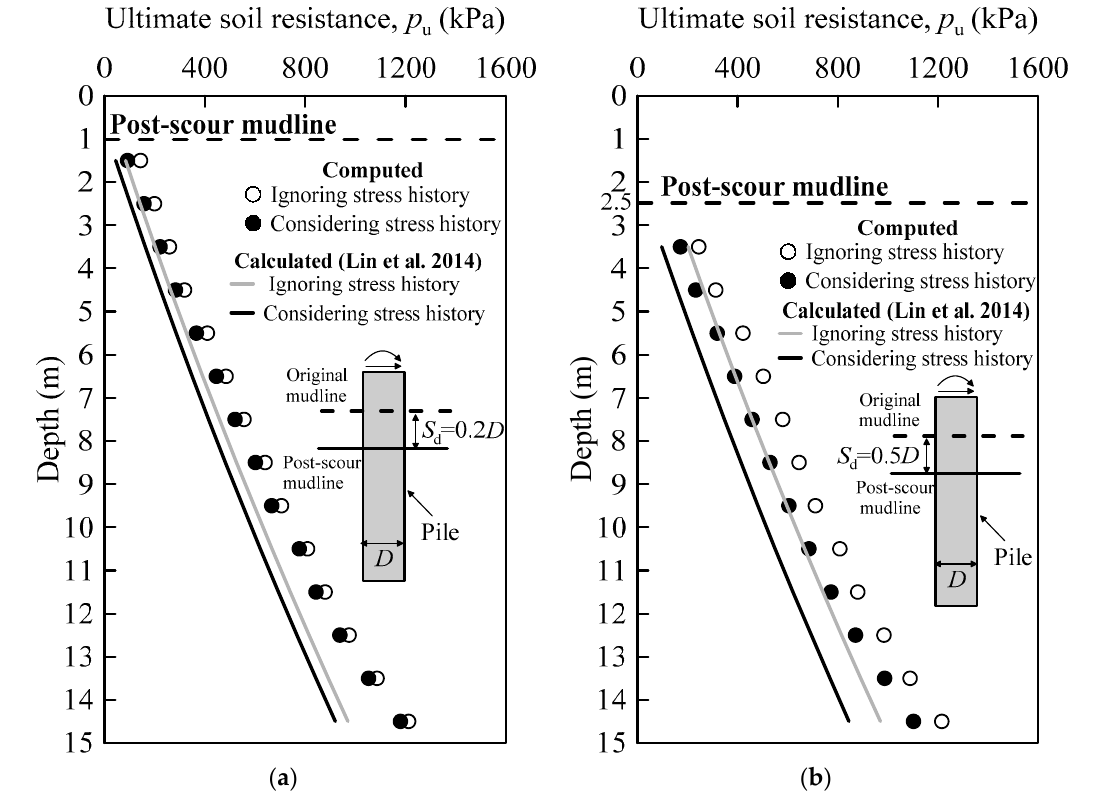
= 0.2 D ; ( b ) S = 0.5 D d d